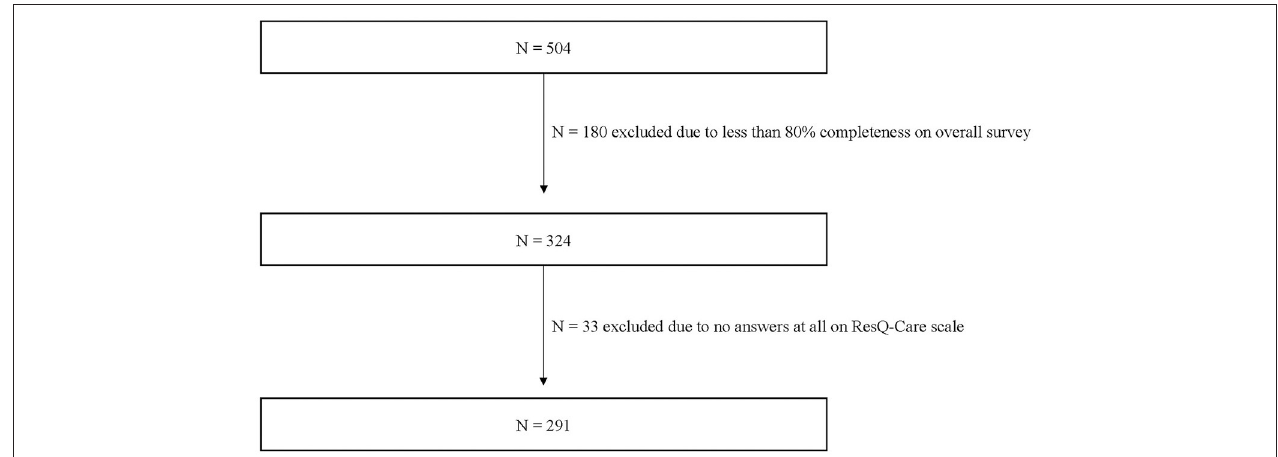
FIGURE 1 | Flow chart of the study population